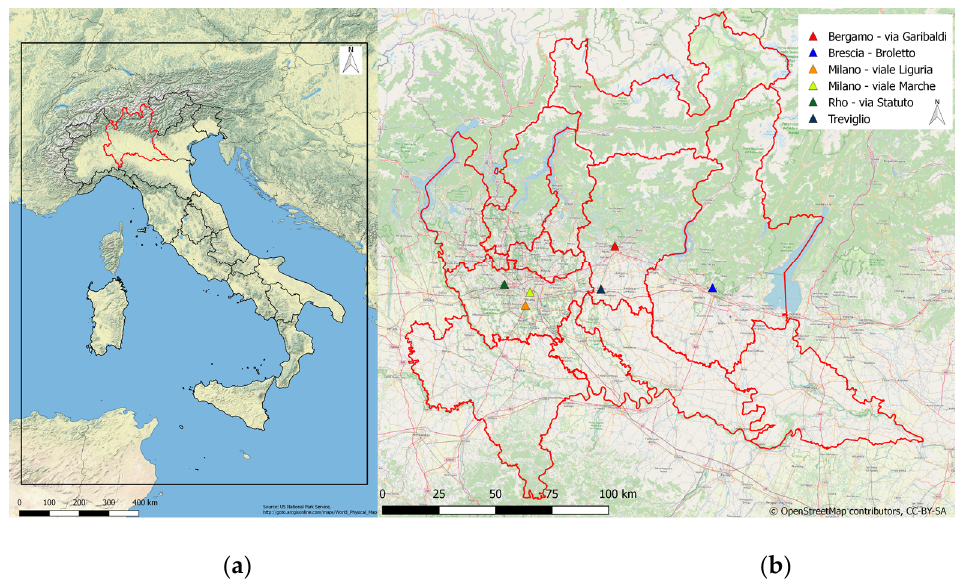
Figure 1. The Italian domain of simulation ( a ) and the Lombardy region domain of study ( b ) with its 13 provinces. The six markers show the position of the air quality stations analysed in this work.